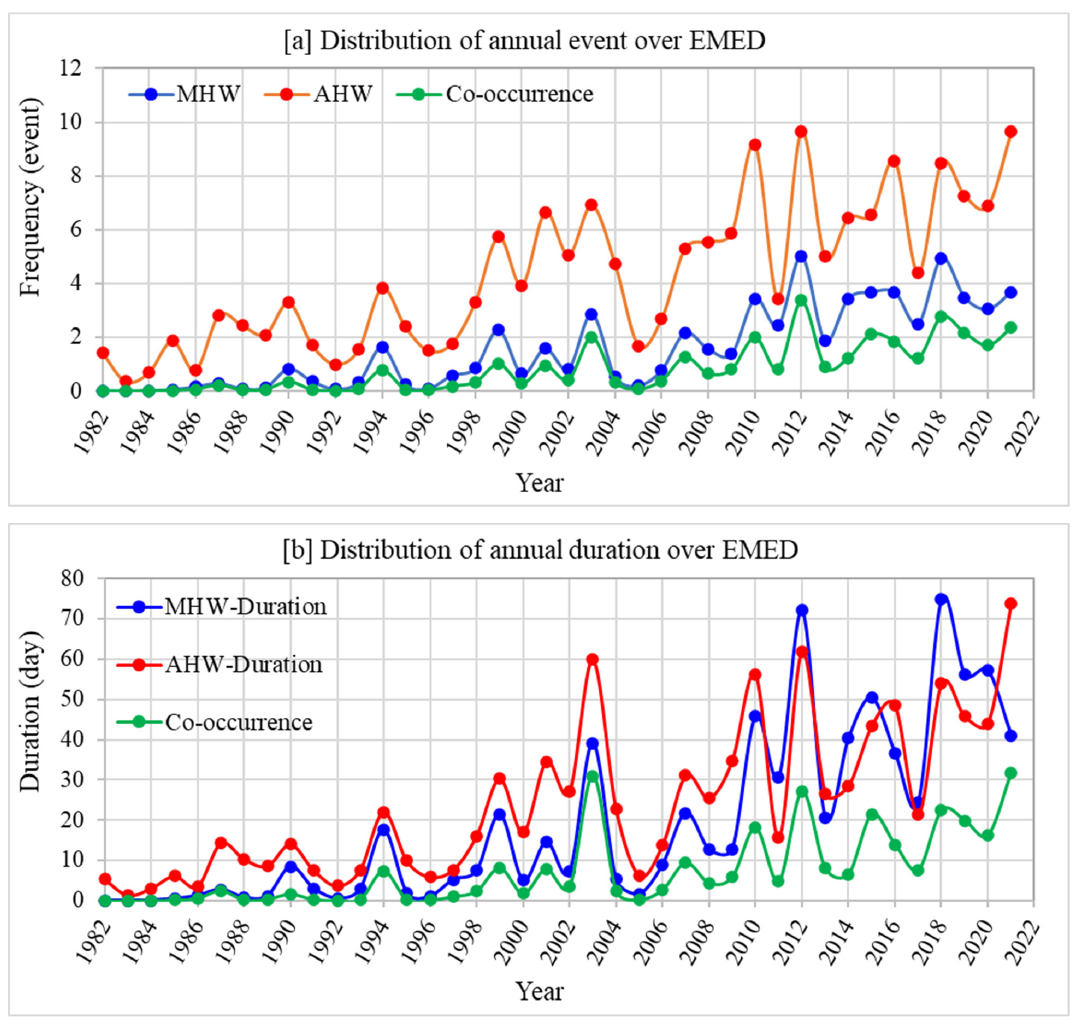
Figure 7. Annual AHWs (continuous red line) and MHWs (continuous blue line) and their co-occurrence (continuous green line) over the study period (1982–2020) for ( a ) frequency and ( b ) duration. Throughout the study period, an increase in the co-occurrence of frequency and total days was observed in approximately 0.6 ± 0.03 events/decade and 5.5 ± 1.1 days/decade,